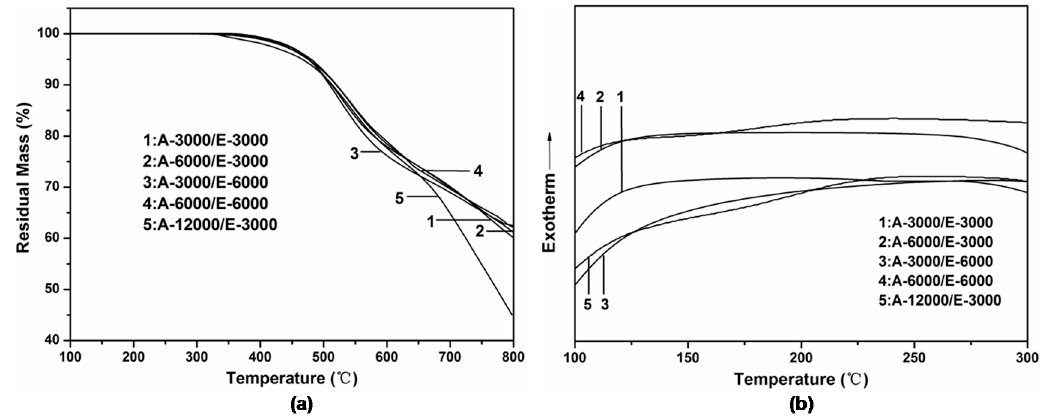
Figure 6. ( a ) Thermogravimetric analysis (TGA) traces of adhesive; ( b ) differential scanning calorimetry (DSC) curves of adhesives.